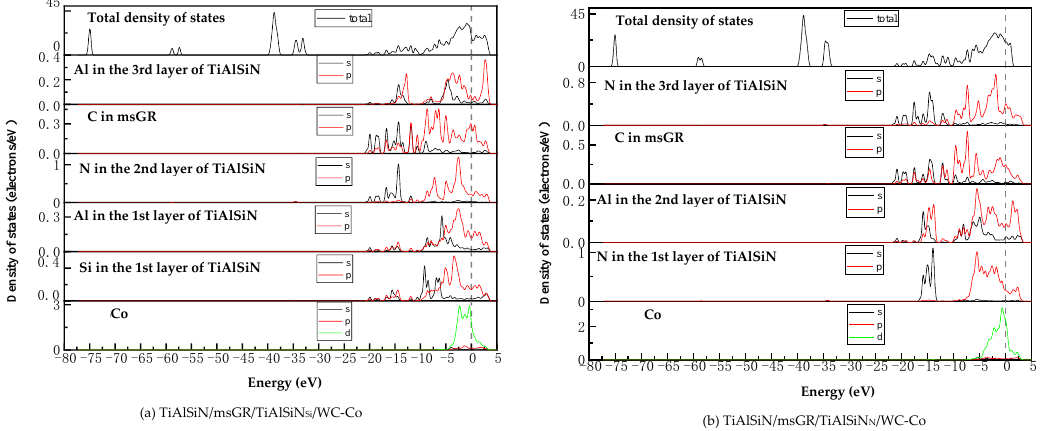
Figure 17. TDOS and PDOS of the interface models with the matrix doped with defective graphene.